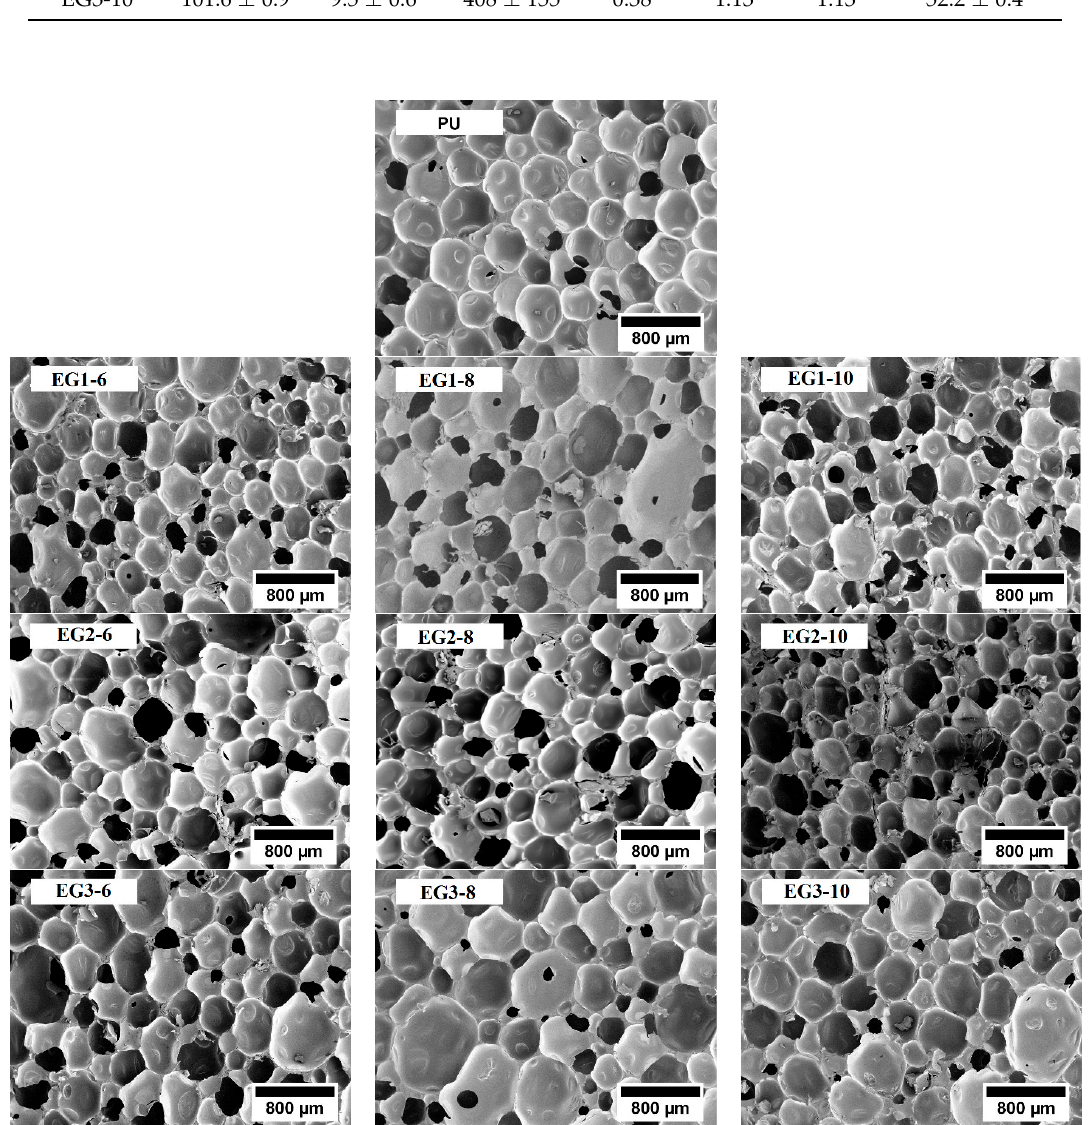
Figure 1. SEM micrographs of the growth plane of rigid polyurethane foam (RPUF) samples.